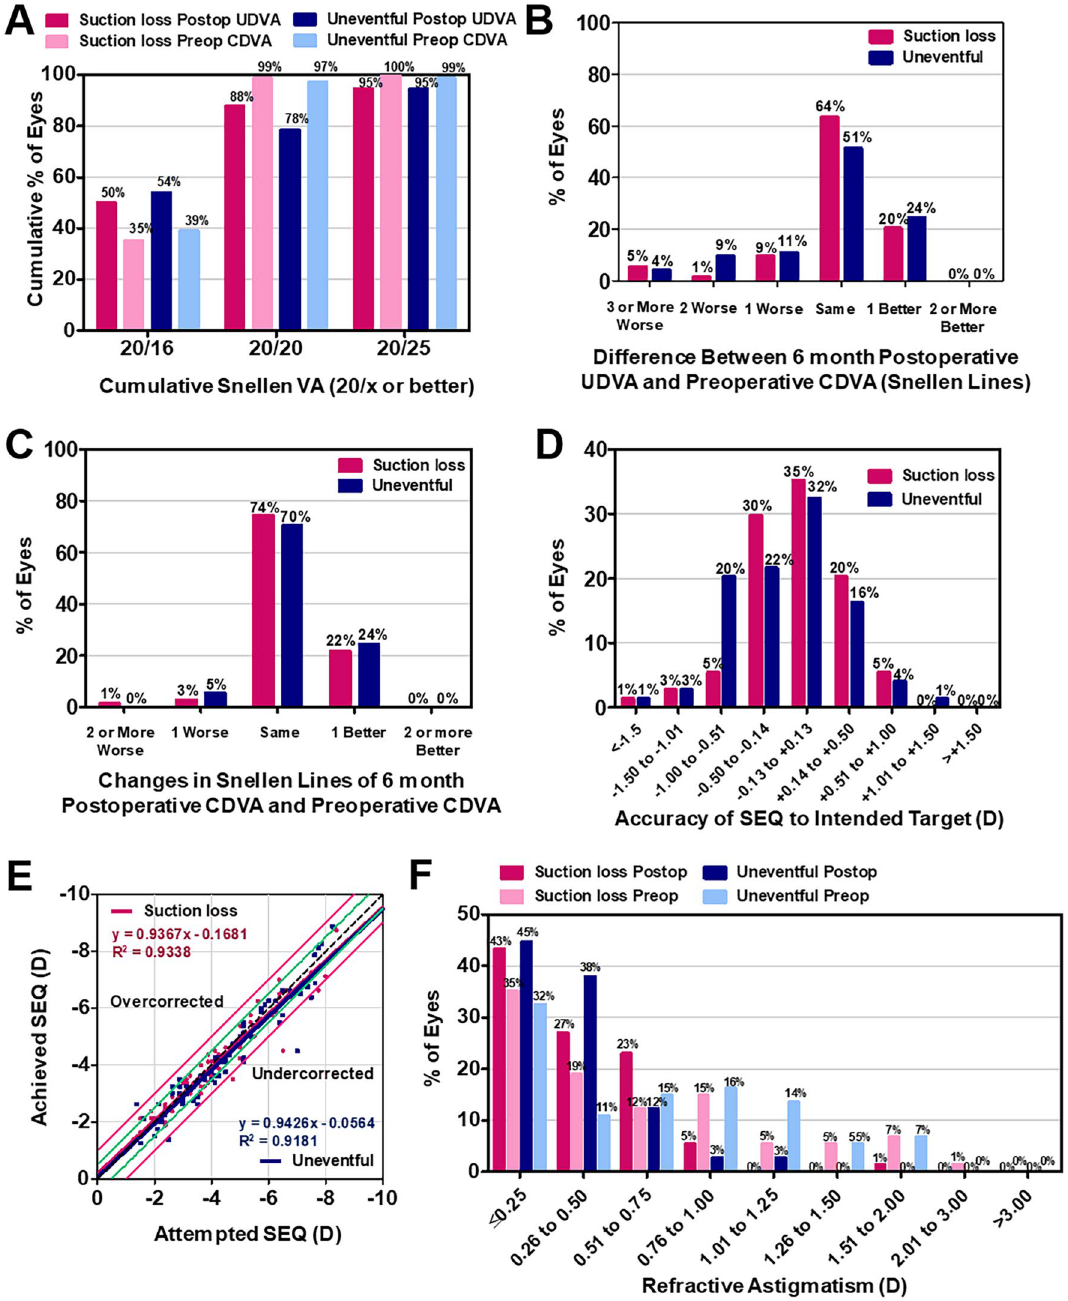
( A ) Cumulative 6-month postoperative uncorrected distance visual acuity (UDVA) and preoperative corrected distance visual acuity (CDVA). Changes in the Snellen lines of ( B ) postoperative UDVA and ( C ) CDVA relative to the preoperative CDVA. ( D ) Accuracy of the spherical equivalent refraction (SEQ) relative to the intended target and ( E ) the attempted versus achieved changes in SEQ at 6 months postoperatively. ( F ) Refractive astigmatism before and 6 months after the surgery. D